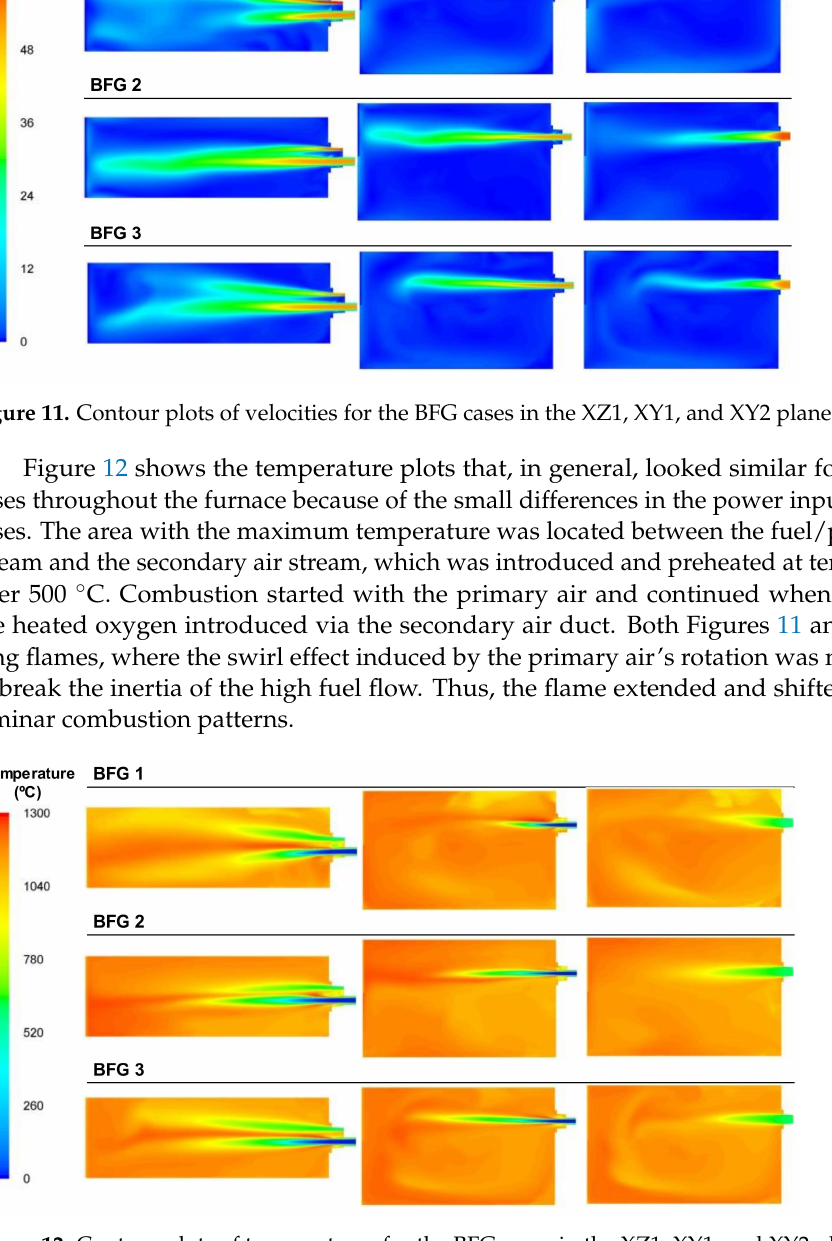
Figure 12. Contour plots of temperatures for the BFG cases in the XZ1, XY1, and XY2 planes. In the burner area where the combustion took place, the way the combustion flame extended as the air flow decreased can be deduced from the temperature plots. This is confirmed by the plots of the OH concentrations, which were often related to the flame’s front development. Figure 13 includes the plots of the OH concentration for the BFG cases, where it can be seen how the OH production occurred far from the inlets as the air flow decreased. It can also be seen how the fluid dynamics inside the furnace, with large flow streams and recirculated streams, caused the highest OH concentrations to deviate from the flame front, as